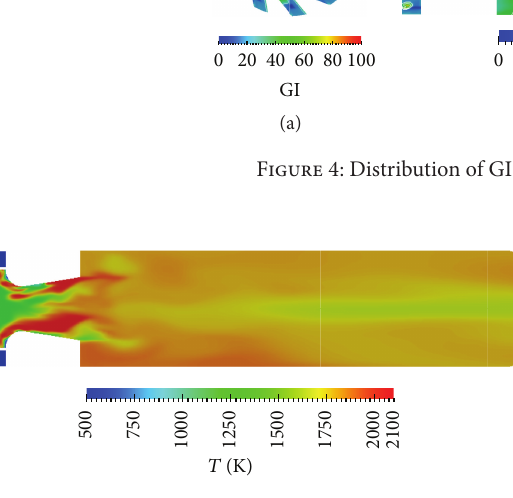
Figure 5: Predicted temperature field at a time step in a plane through combustor, calculated using mixture fraction-scalar dissi- pation rate based LFM (see (1)–(4)) for NG-FGR20 flame.